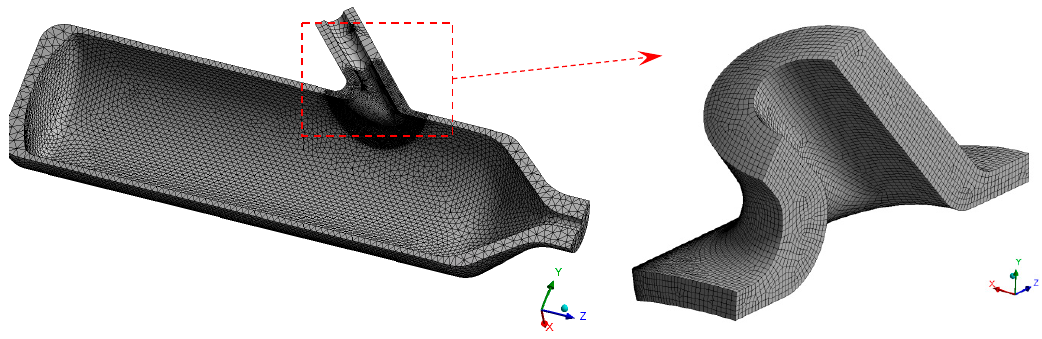
Figure 25. Finite element model of the pressure vessel with nozzle intersection geometry.